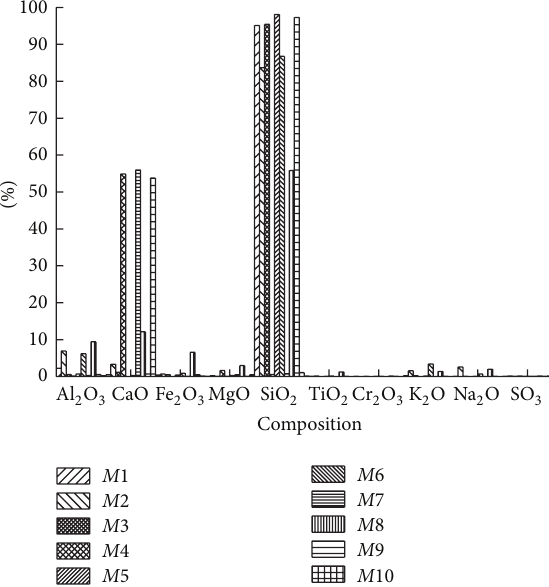
Figure 4: The chemical composition of aggregates.